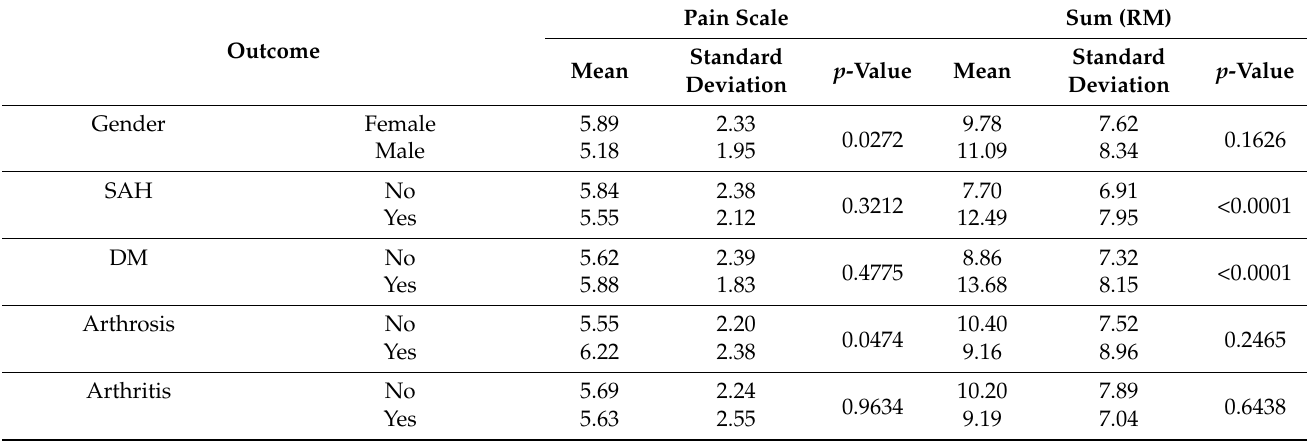
Table 2. Population characteristics and the level of pain and functional